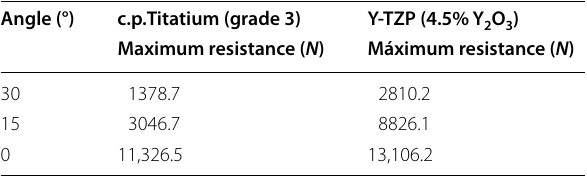
Flexural test at different angles